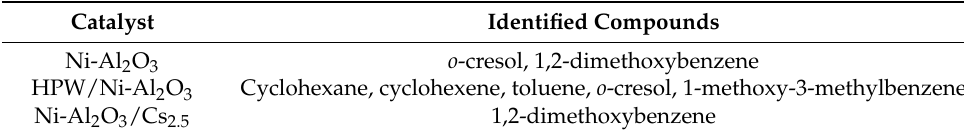
Table 2. Identified products per catalyst in the Ni-Al 2 O 3